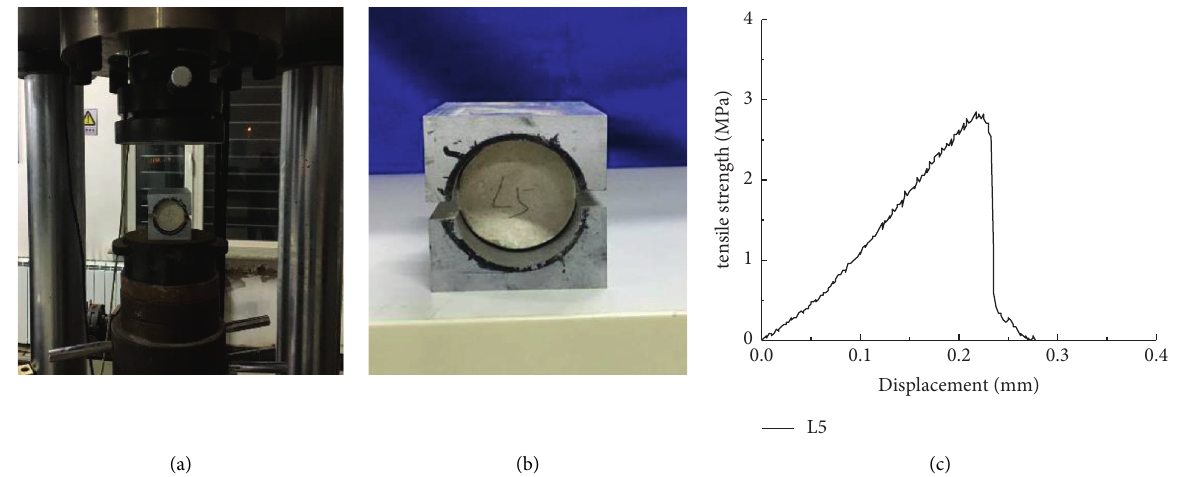
Figure 6: Tensile strength test of similar materials covered by the study. (a) Tensile strength test. (b) Tensile strength test specimen. (c) Stress-displacement curve of the fifth group of specimens from the tensile